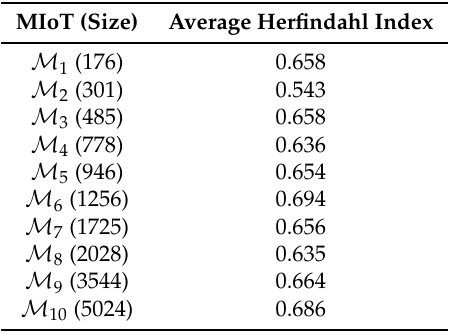
Table 9. Average Herfindahl Index of virtual IoTs against the size of MIoTs (unsupervised approach). MIoT